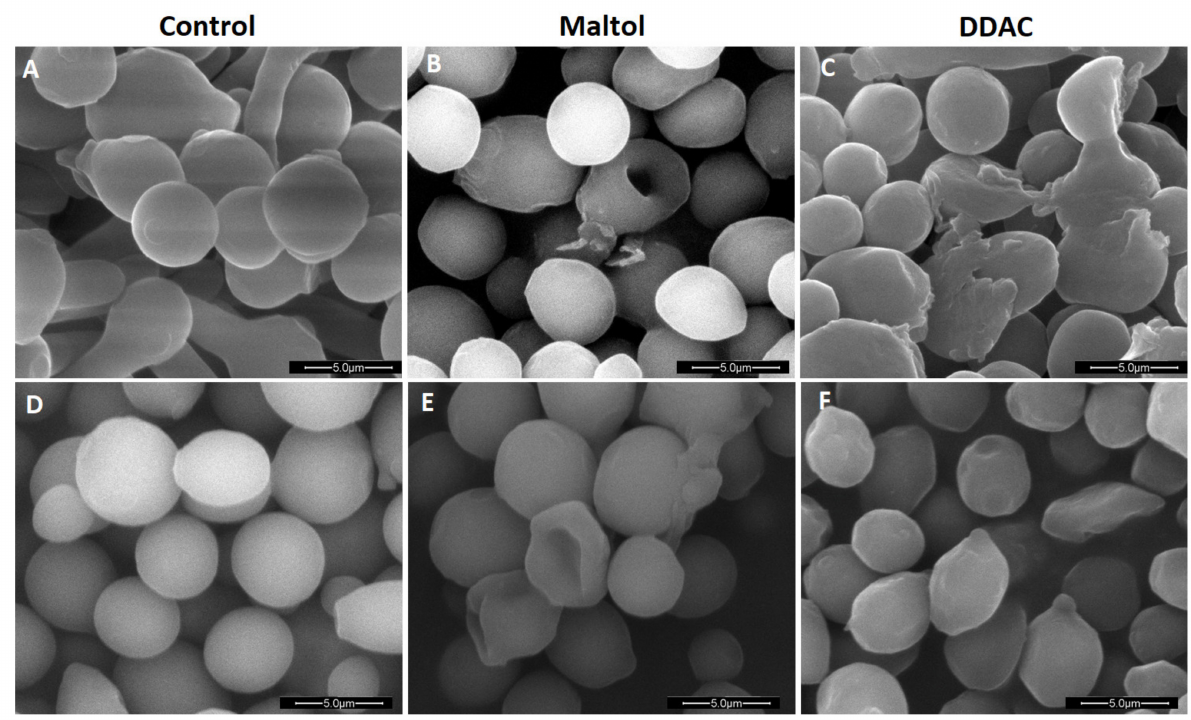
Figure 11. Scanning electron microscopy (SEM) images of Candida albicans treated with ( A ) H 2 0, no-treatment control, ( B ) maltol at 10,000 ppm, ( C ) DDAC at 1000 ppm; and Aspergillus brasiliensis treated with ( D ) H 2 0, no-treatment control, ( E ) maltol at 10,000 ppm, and ( F ) DDAC at 500